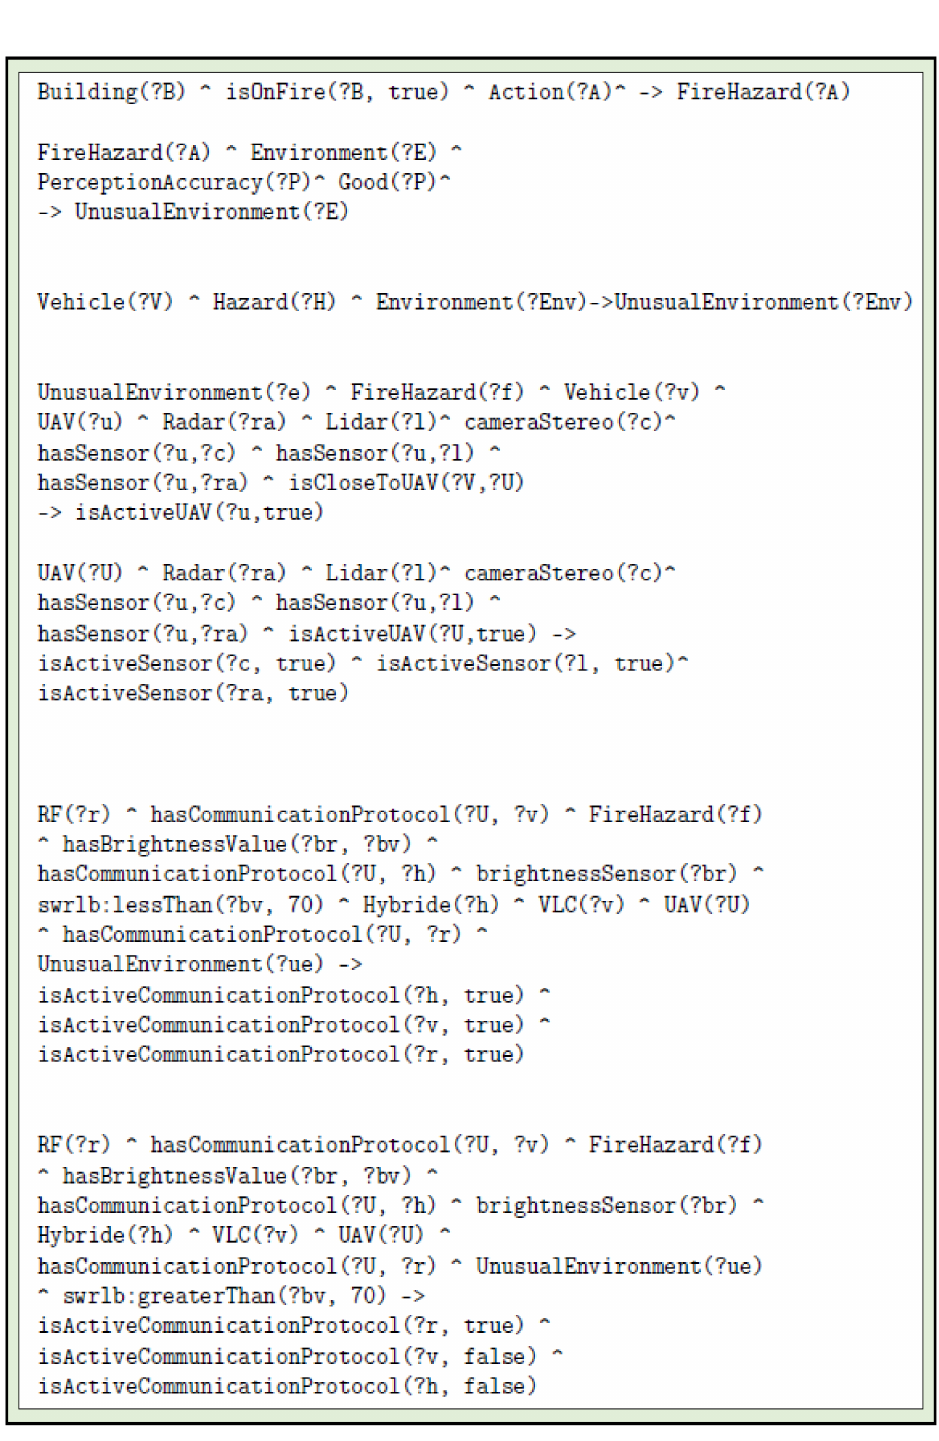
Figure 31. Set of rules for the fire hazard section of the use case